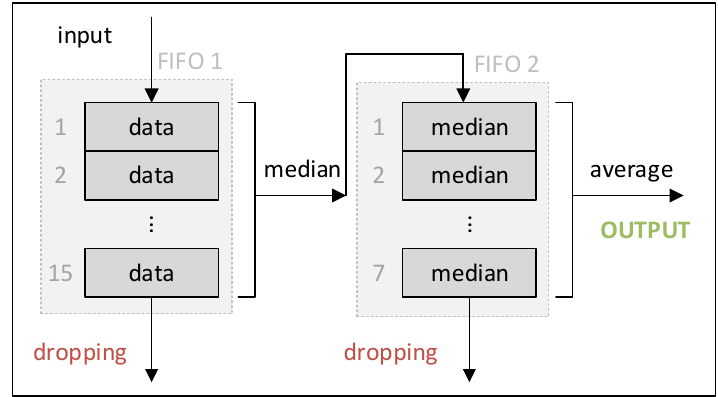
Figure 13. Procedure of filtering by averaging of moving medians.